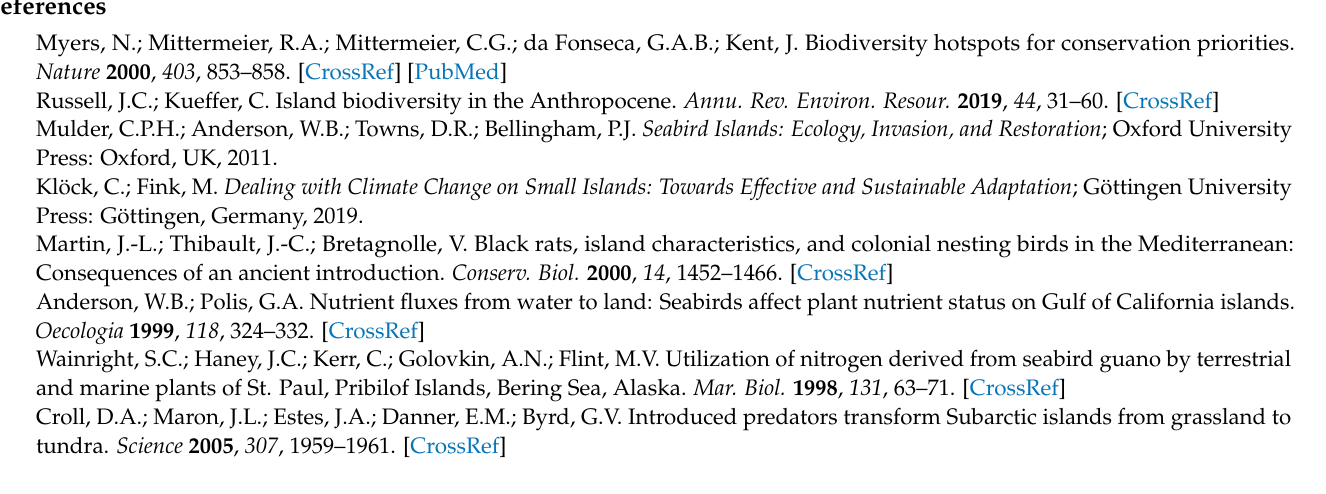
islet-level variables tested; Table S2: Name description, and source of all regional-level variables tested; Table S3: Islet-level data; Table S4: Regional data; Table S5: Pearson’s correlation coefficients for islet-level continuous independent variables; Table S6: Pearson’s correlation coefficients for regional-level independent variables; Figures S1–S5: R output for all islet-level models